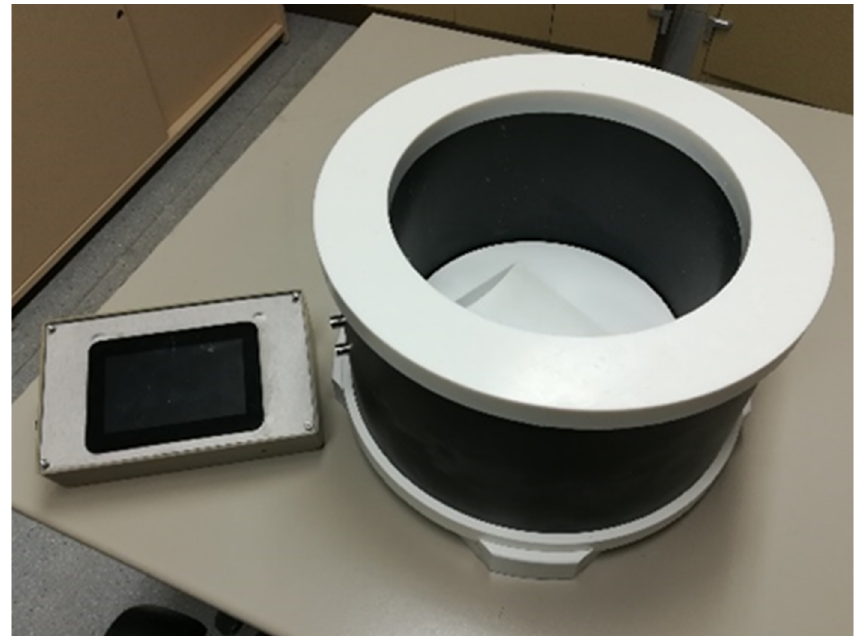
Figure 7 . SmartFibreC® inductive equipment for measuring the amount and orientation of steel Figure 7. SmartFibreC®inductive equipment for measuring the amount and orientation of steel fibres fibres in hardened concrete. in hardened